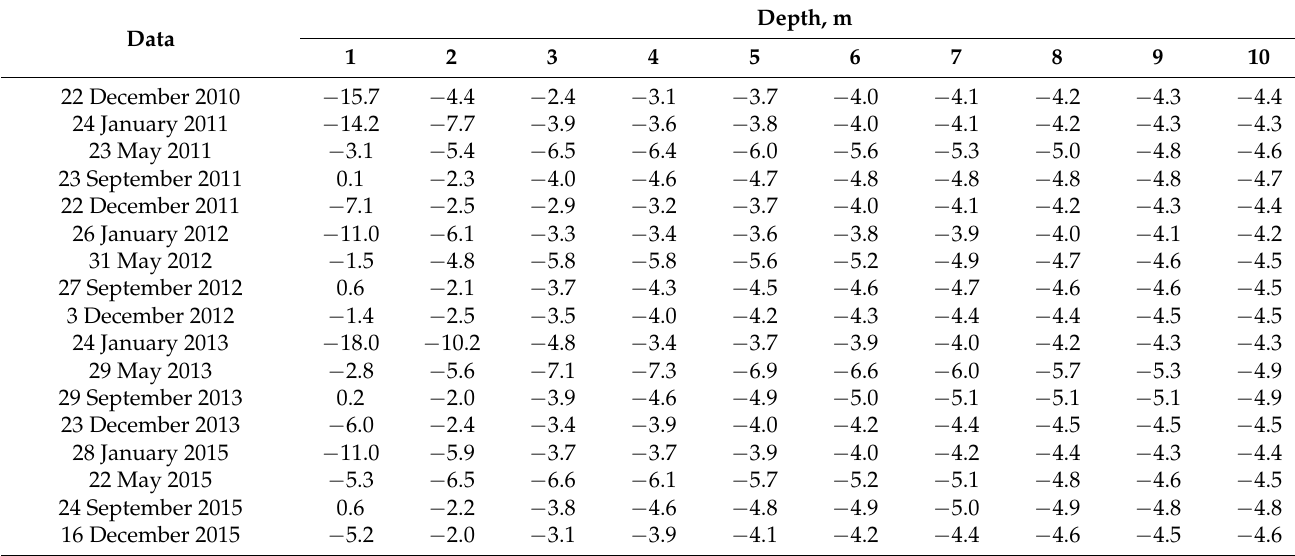
Table 4. Ground temperatures in borehole # 60, ◦ C.